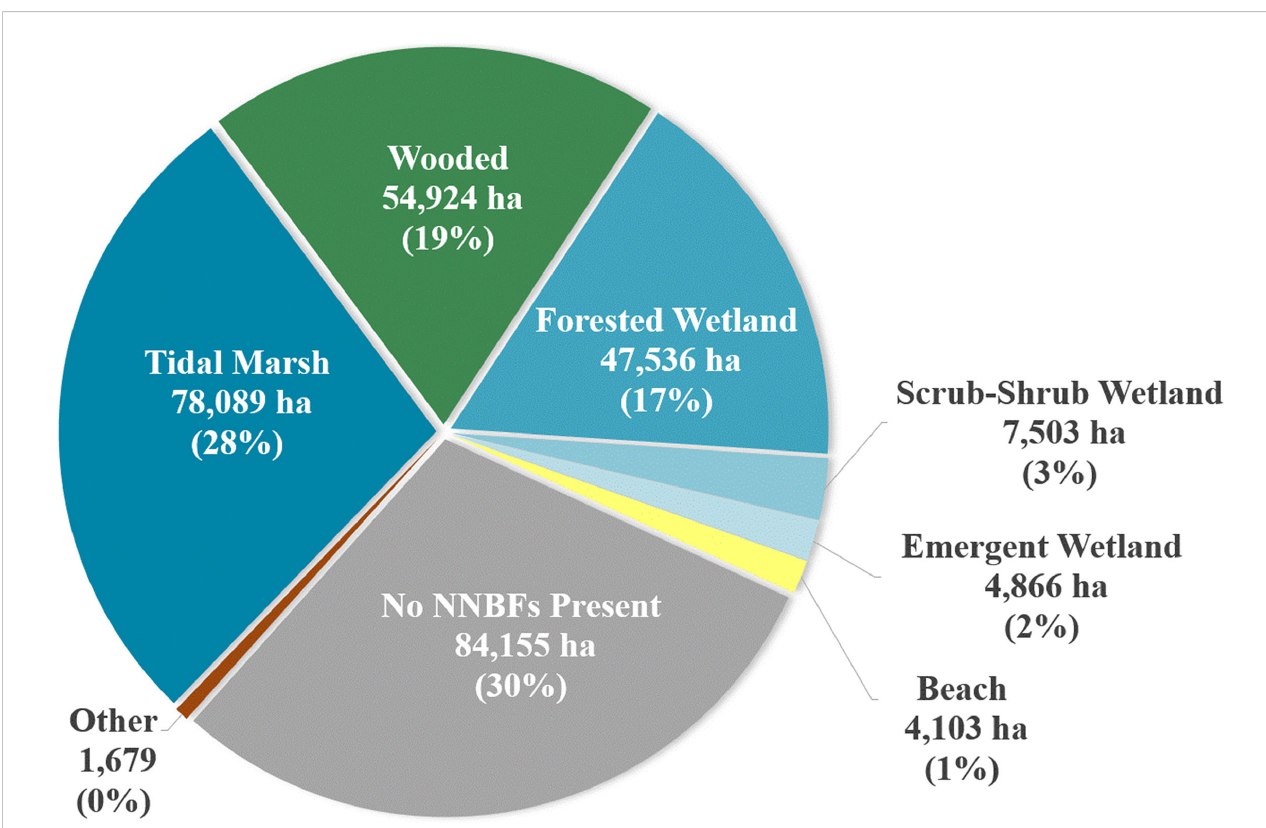
FIGURE 4 Summary of areal extent within the less than 10-ft study area, by NNBF Type. The ‘ Other ’ category includes NNBF types that constitute less than 1% of the study area, including: scrub-shrub (1,609ha), dune (52 ha), marsh sill (12 ha), breakwater (5 ha), and oyster sill (2